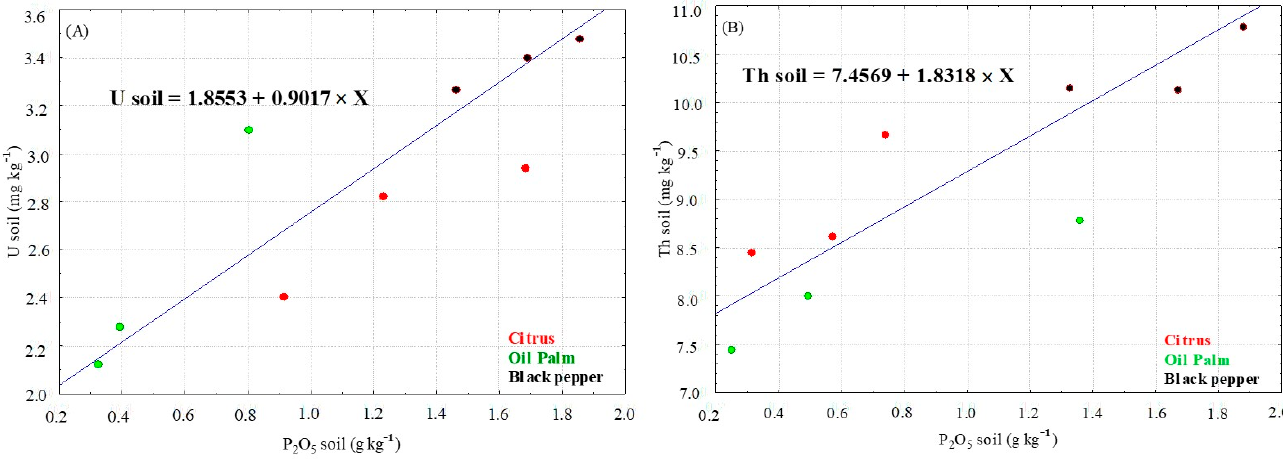
Figure 3. Elemental concentration ratio between uranium ( A ) and thorium ( B ) and the P 2 O 5 content in the cultivated soils.